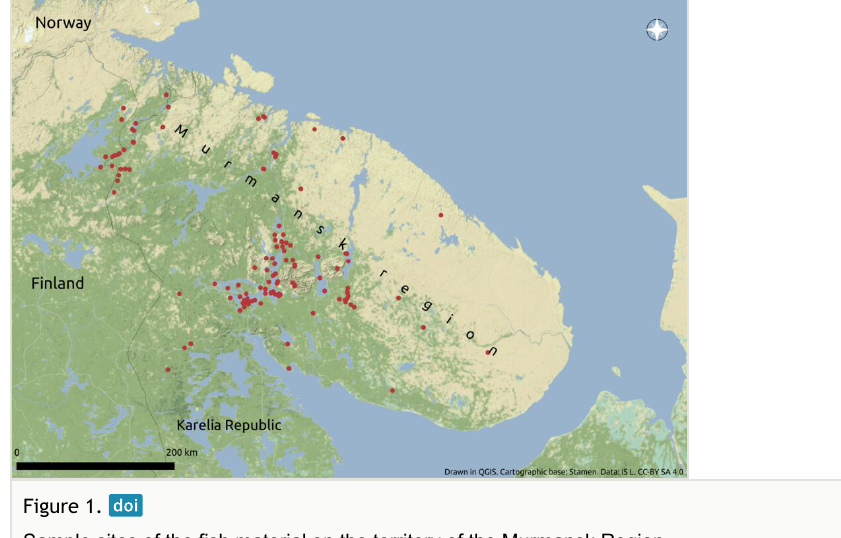
Figure 1. Sample sites of the fish material on the territory of the Murmansk